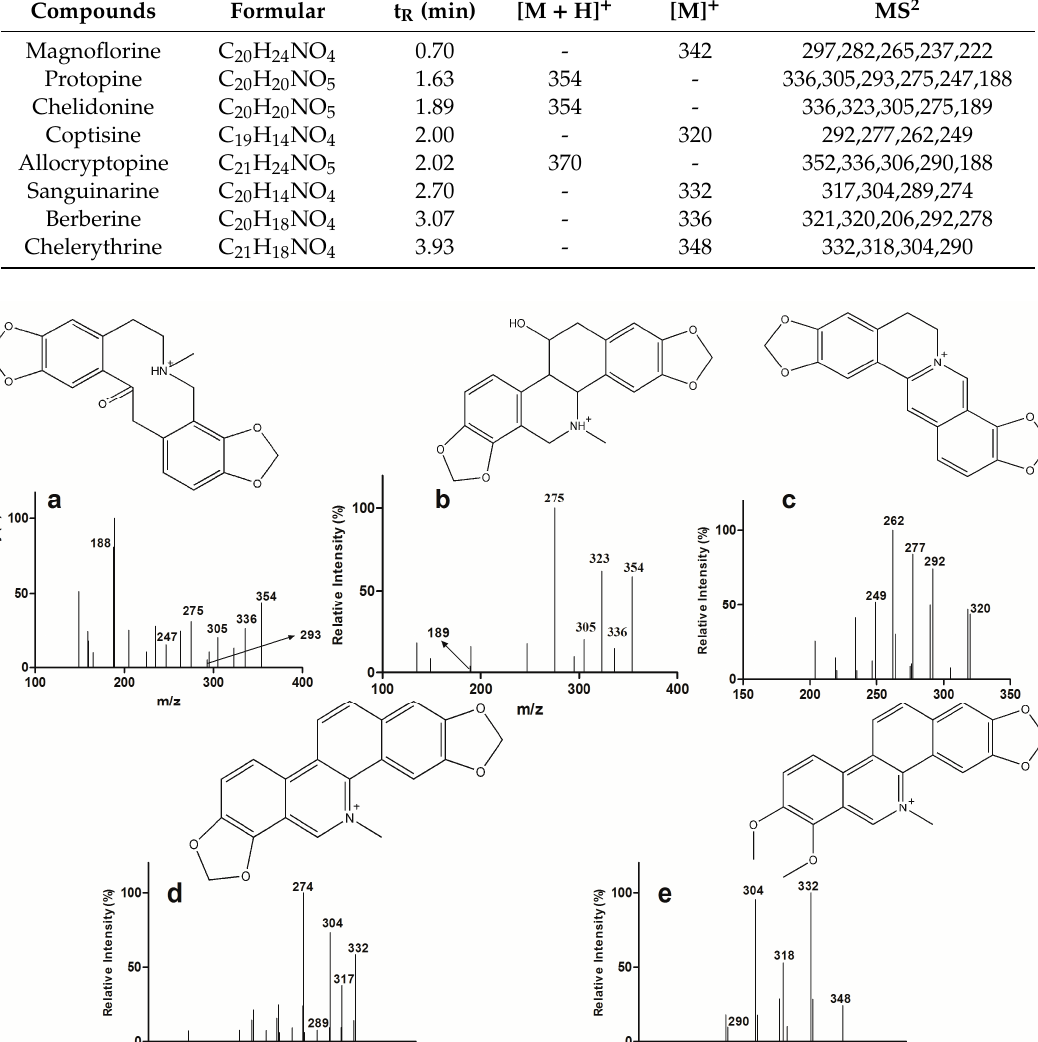
Table 5. Retention time ( t R ) and MS 2 fragment ions of eight alkaloids identified in Ch. majus.